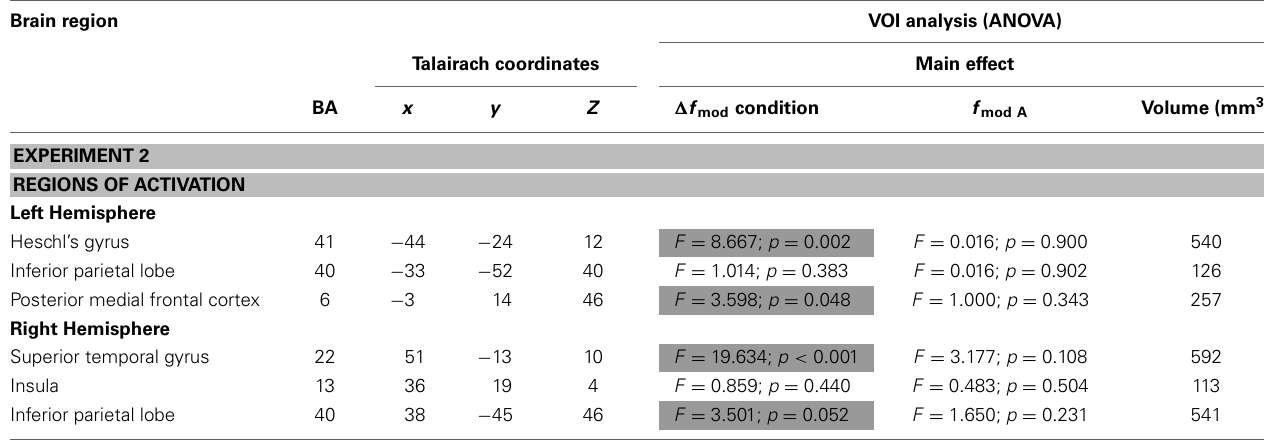
Table 3 | Brain regions (BA-Brodmann area; x,y,z -Talairach coordinates) showing positive deflections of the BOLD signal in at least one of the three (cid:2) f mod conditions compared to the baseline ( t = 4 . 5, p < 0 . 002) for each of the two f c (1, 4kHz) tested in Experiment 2 and the results of ANOVAs within the resulting